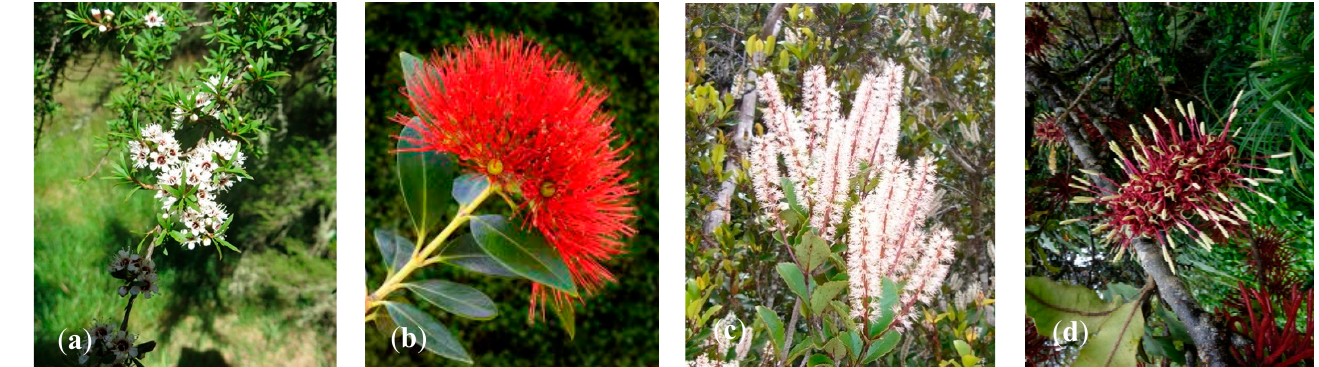
Figure 1. Native NZ plants included in this study: ( a ) K ā nuka ( Kunzea ericoides ), photo by Kathy Warburton, source Wikimedia Commons; ( b ) southern R ā t ā ( Metrosideros umbellata ) , photo by Sid Mosdell, source Fickr; ( c ) K ā mahi ( Weimania racemose ), photo by Alan Liefting, source Wikipedia; ( d ) Rewarewa ( Knightia excelsa ), photo by John Barkla, source Wikimedia commons. All under creative commons licence.